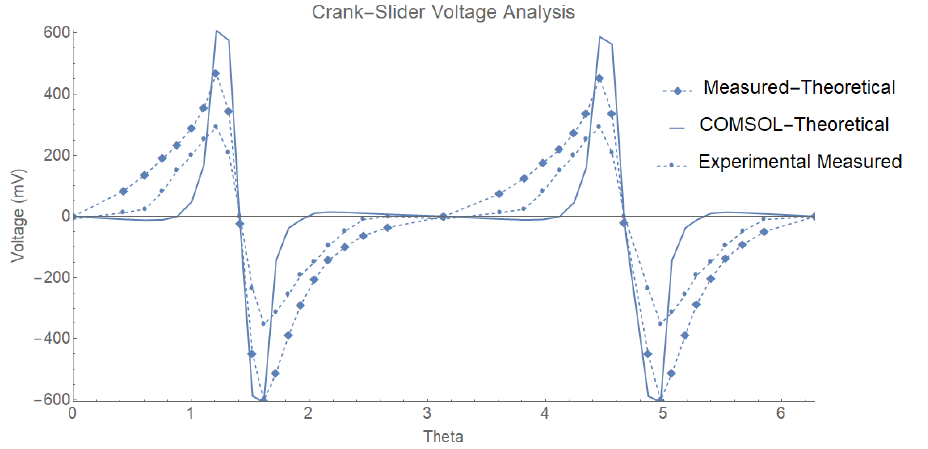
Figure 11. Representation of the transduction coefficient ( Φ ) based both the measured and COMSOL prediction values from Figure 10 with the l value for the crank-slider harvester. This image represents a one-half stroke from 0 to π of the crank, which would originate at − 25 mm and extend to +25 mm from the center of the coil.